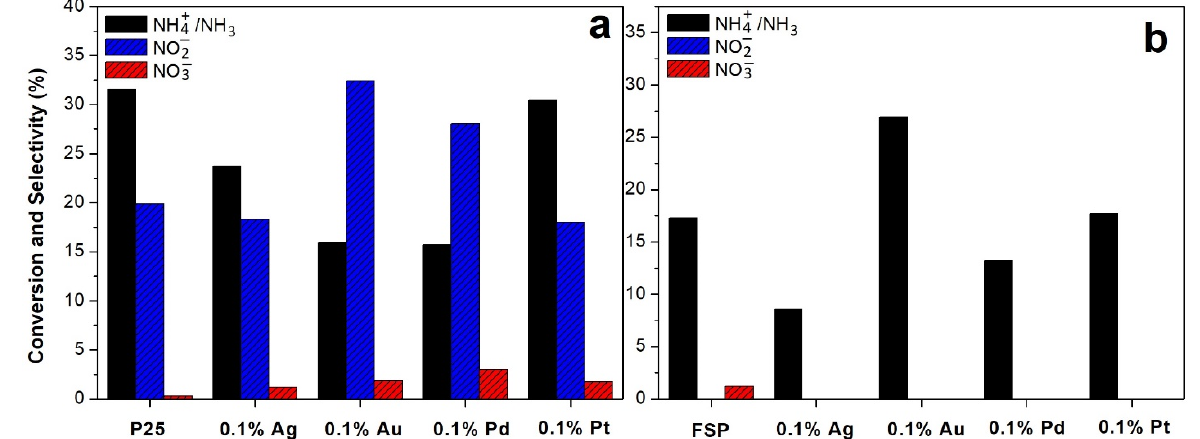
Figure 6. Ammonia conversion and NO x − selectivity after 240 min of irradiation with different co-catalysts on ( a ) P25 at pH 11.5 and ( b ) FSP at pH 4.8. Conversion and selectivity (%) figures on y-axis of diagrams ( a , b ).